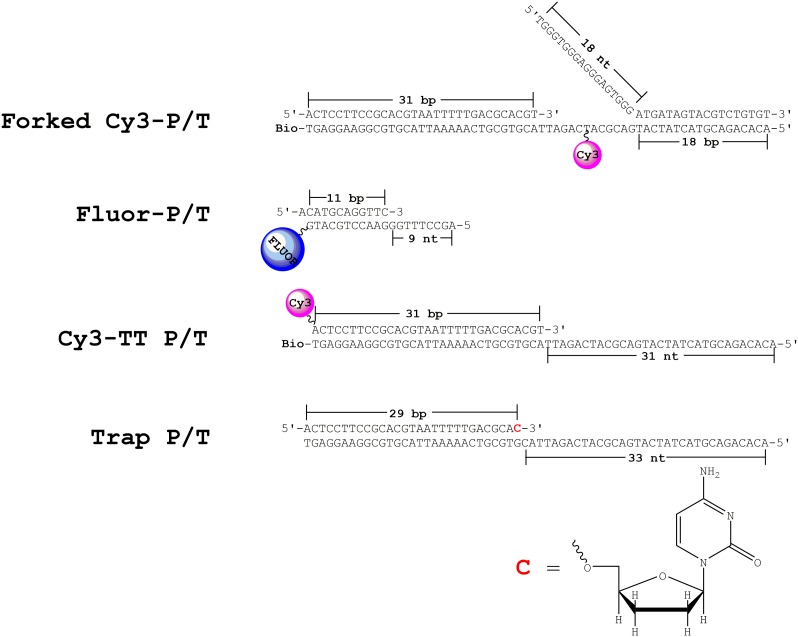
DNA substrates.The forked Cy3-P/T and Cy3-TT P/T DNA substrates contain Cy3 donor labels and were utilized for FRET-based studies. The FLUOR-P/T DNA substrate contains a 3’-terminal fluorescein label and was utilized for anisotropy measurements. The Trap P/T substrate contains a 3’-dideoxy-terminated primer and was utilized as a passive trap to monitor primer extension under single turnover conditions. C denotes a dideoxy-terminating cytosine nucleotide and the structure is shown in the bottom panel.